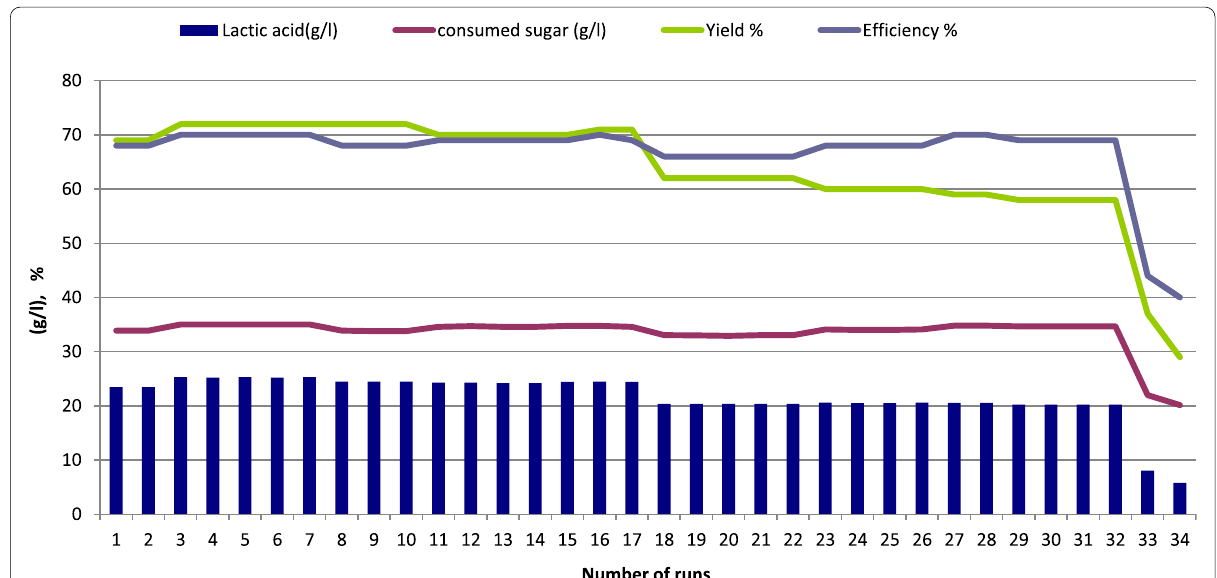
Fig. 5 Lactic acid production from salted cheese whey and whey permeate mixture (1:1, contained 10% sugar) using immobilized cells of Enterococcus faecalis -58